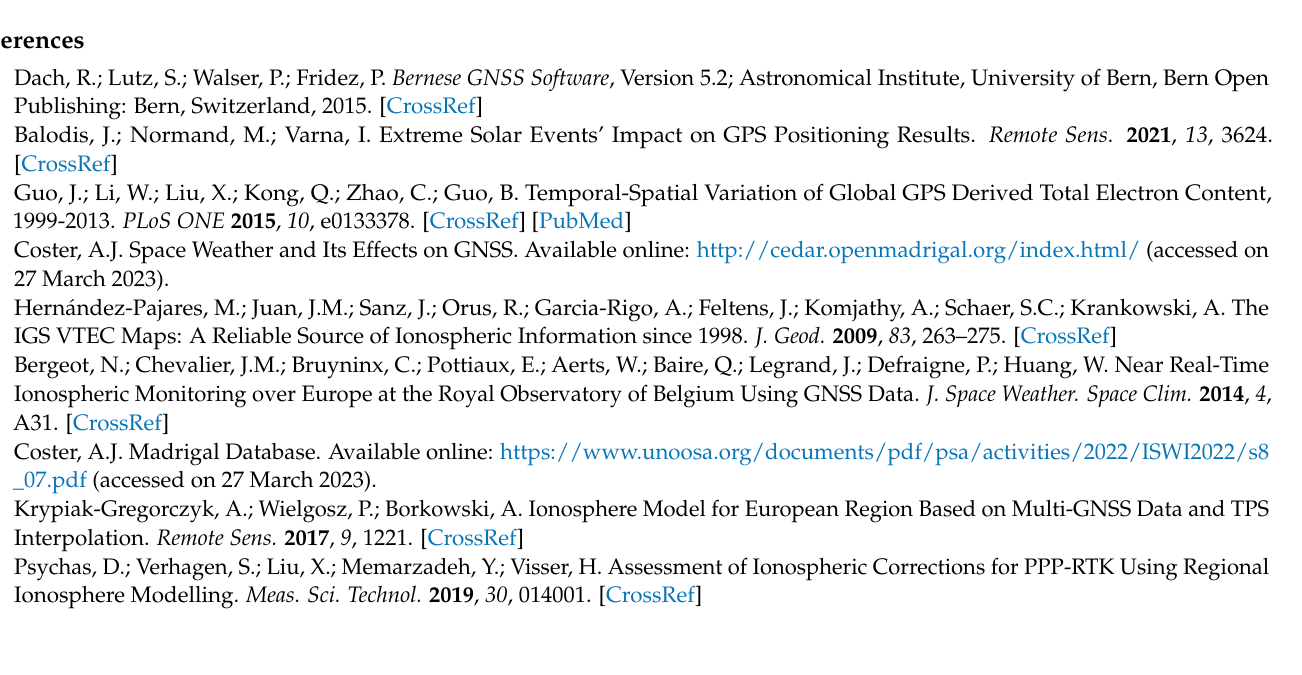
Table S1: ROTI max values per day and (per each hour ROTI*1.e04); N—count of faulty solutions; C— count of cycle slips; Table S2: discrepancy (m) max values per day and per hour; N—count of faulty solutions (degraded GPS observations); C—count of cycle slips; Table S3: solar events, TEC, cycle slips (CSLP), and count of daily faulty solutions (>10 cm); Table S4: subsets T . Subsets of stations where faulty positioning solutions simultaneously occurred in March 2015; Table S5: discrepancy samples related to Figure 4 (subset W); Table S6: peak subsets (domes, summary discrepancy, ROTI); Table S7: ionospheric scintillation duration exposed by subsets B , P’ , P (according to Figure 2); Table S8: list of clouds from Table S4 in groups: (8.1) subsets of cloud stations belonging to each group of five-clouds, (8.2) subsets of stations belonging to each group of five-clouds 9 subset P prim); Table S9: clouds of March 1 group and results of intersection with corresponding clouds of other groups; Table S10: intersection results of cloud subsets within each subset group; Table S11: characteristics of individual station discrepancies; Table S12: EGNOS RIMS ground-based station discrepancies SUBSET w); Table S13: registration of the sequentially occurred discrepancies; Table S14: discrepancies (m) of individual RIMS stations in loss-of-lock